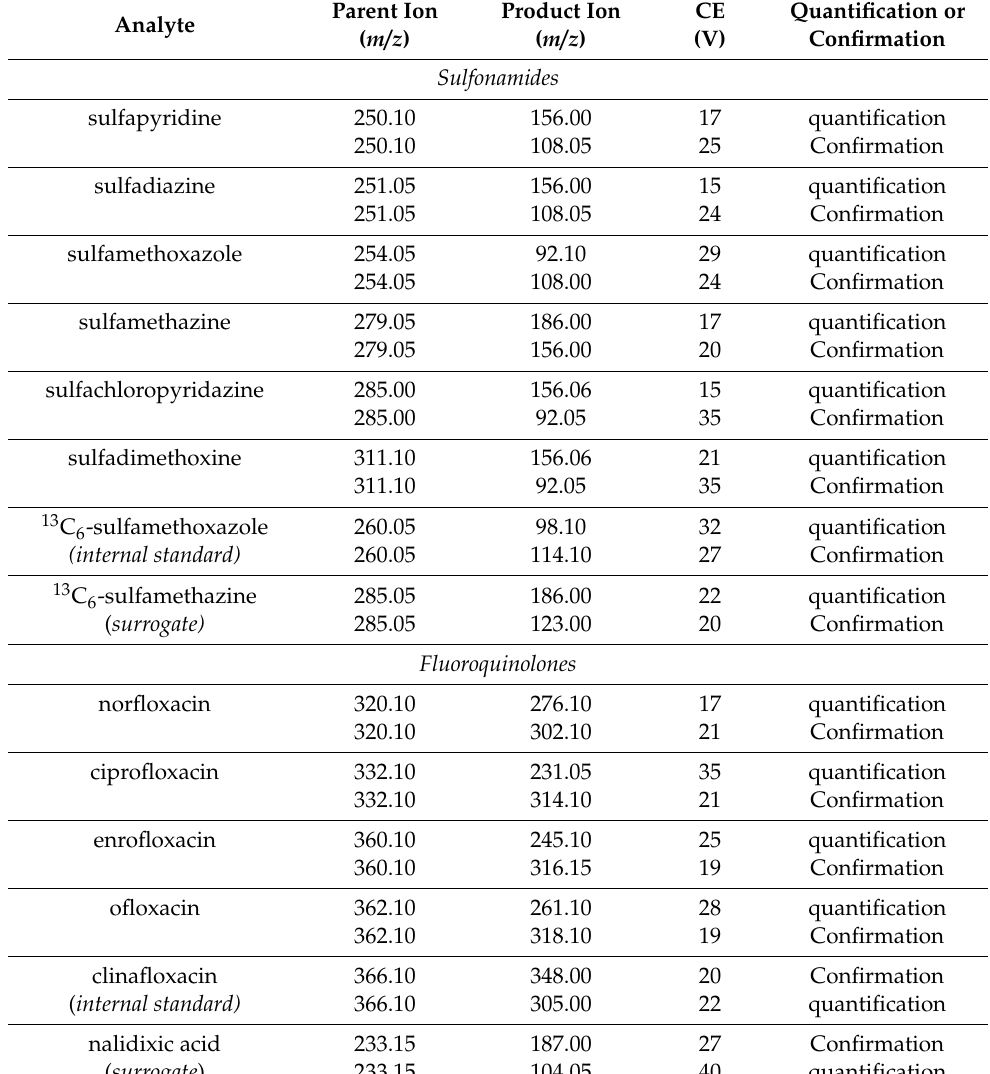
Analytes were detected and quantified using single reaction monitoring (SRM) transitions (Table A2). Confirmation SRMs were used to corroborate the identity of quantified peaks. The mass spectrometer sensitivity varied between analyses, and thus, parameters were optimized with the infusion of 5 µ M simeton in 50:50 20 mM ammonium acetate:methanol prior to each analysis. Typical values for mass spectrometer parameters were scan time 0.02 s; scan width: 0.15; Q 1 / Q 3 : 0.7; spray ◦ voltage: 3300 V; sheath gas pressure: 18 psi; capillary temperature: 300 C; collision pressure: 1.5 mTorr; declustering voltage: − 9 V; and tube lens: 95. Table A2. Single reaction monitoring quantification and confirmation transitions and collision energy (CE) for analytes. Parent Analyte